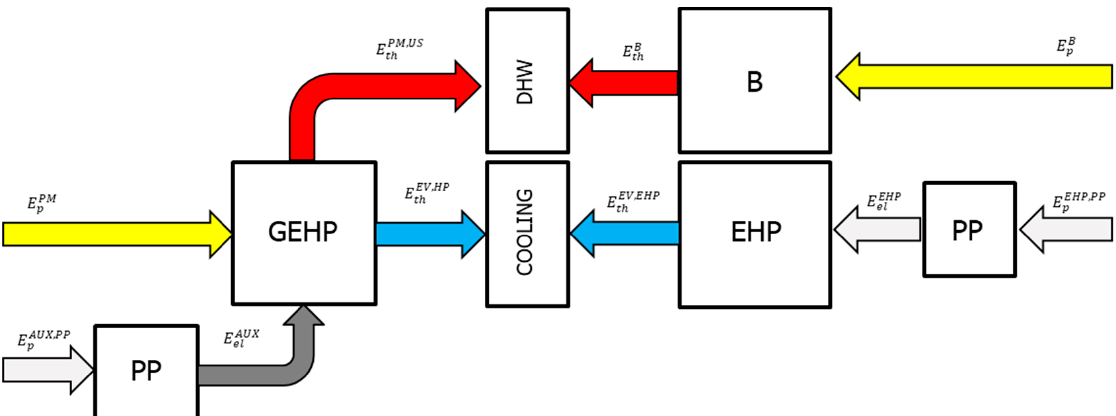
Figure 25. Comparison between GEHP with DHW kit and EHP/B.